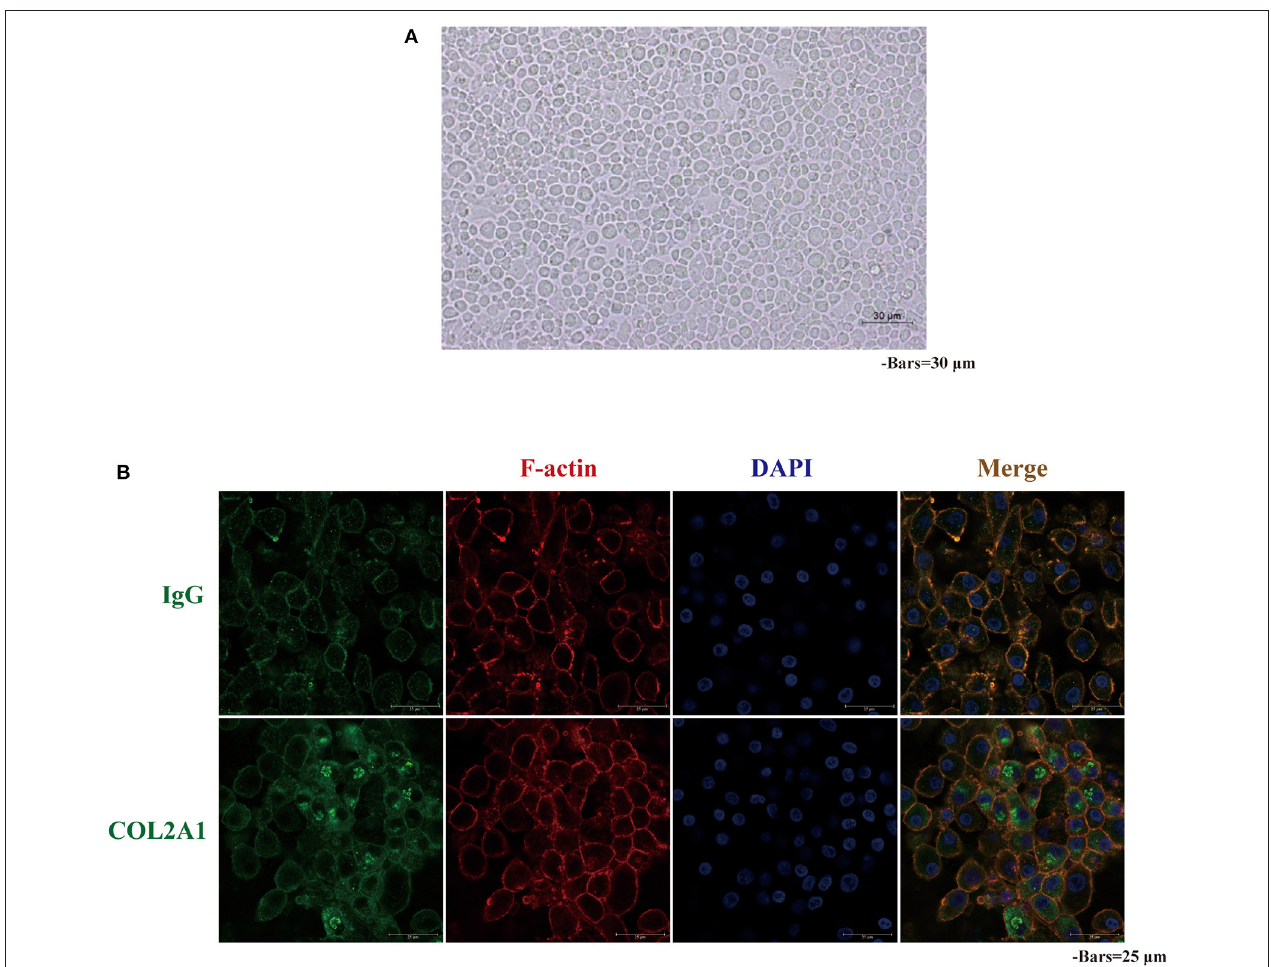
FIGURE 1 | Morphology and COL2A1 expression in primary chicken chondrocyte cultures. (A) After 5 days of culture, the chicken primary chondrocytes were aggregated and had grown with a “paving stone” phenotype; (B) Representative images of immunofluorescence staining showing a strong green fluorescence signal in chicken primary chondrocytes expressing COL2A1. IgG was used as a negative